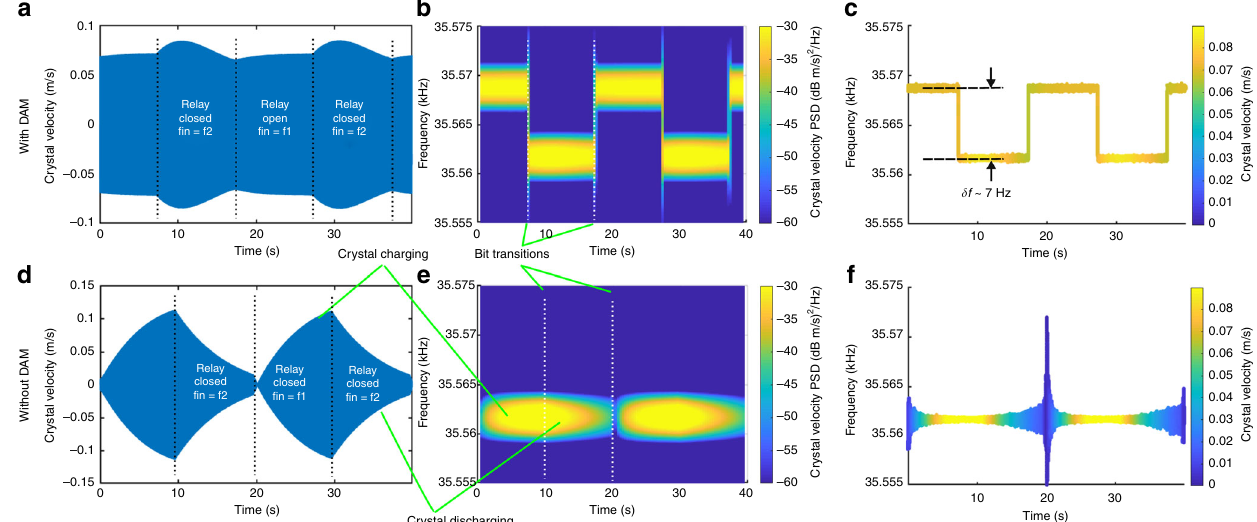
Fig. 5 Measured effect of direct antenna modulation (DAM) to modulate a >300,000 Q resonator with a frequency separation of 7 Hz and an frequency shift keying rate of 0.05 Hz. a – c are with direct antenna modulation (DAM), d – f are without DAM. a , d are the time-domain measurements, b , e are the time-frequency spectrograms, and c , f are the Hilbert transforms. Note that one of the resonant frequencies is intentionally detuned to minimize the effect of different Q on the amplitude of the output signal